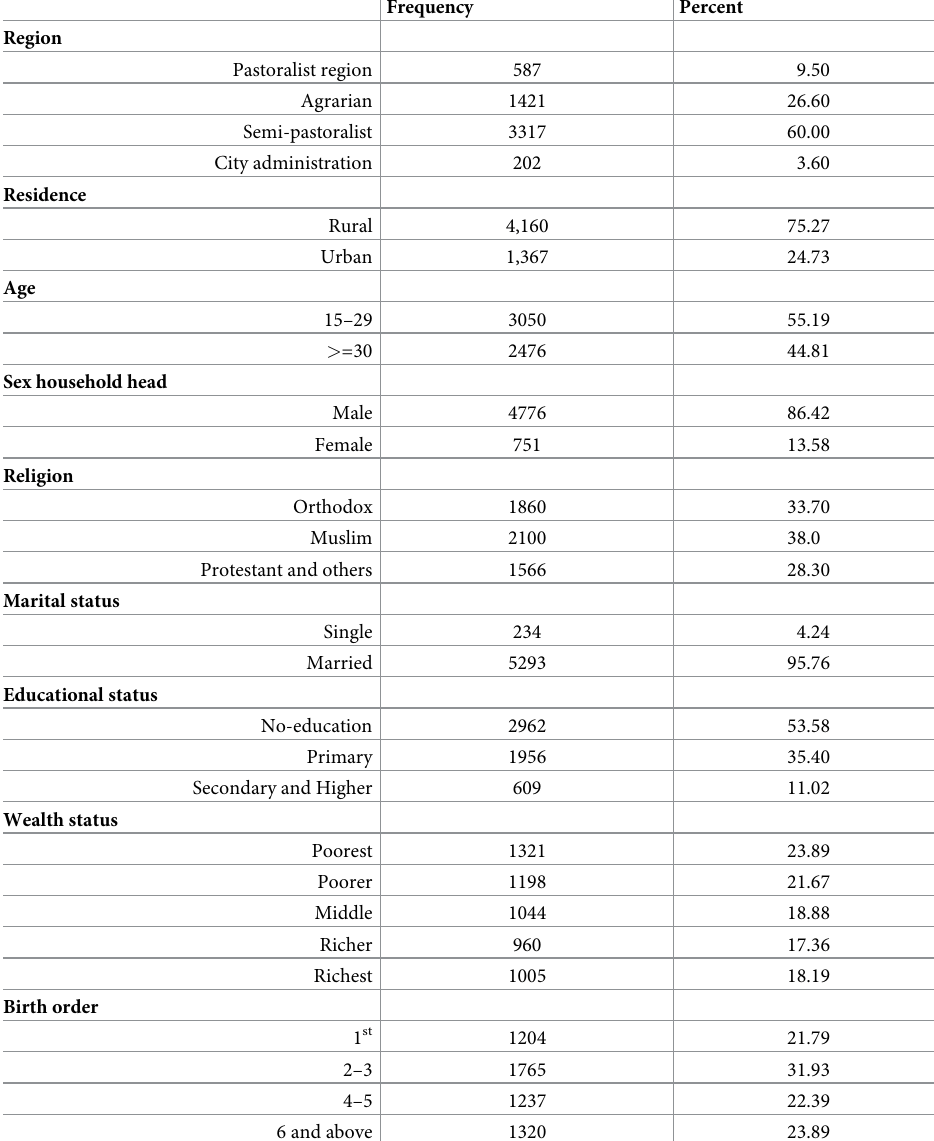
Table 1. Socio-demographic characteristics of the study population (Weighted, N = 5527). Frequency Percent Region Pastoralist